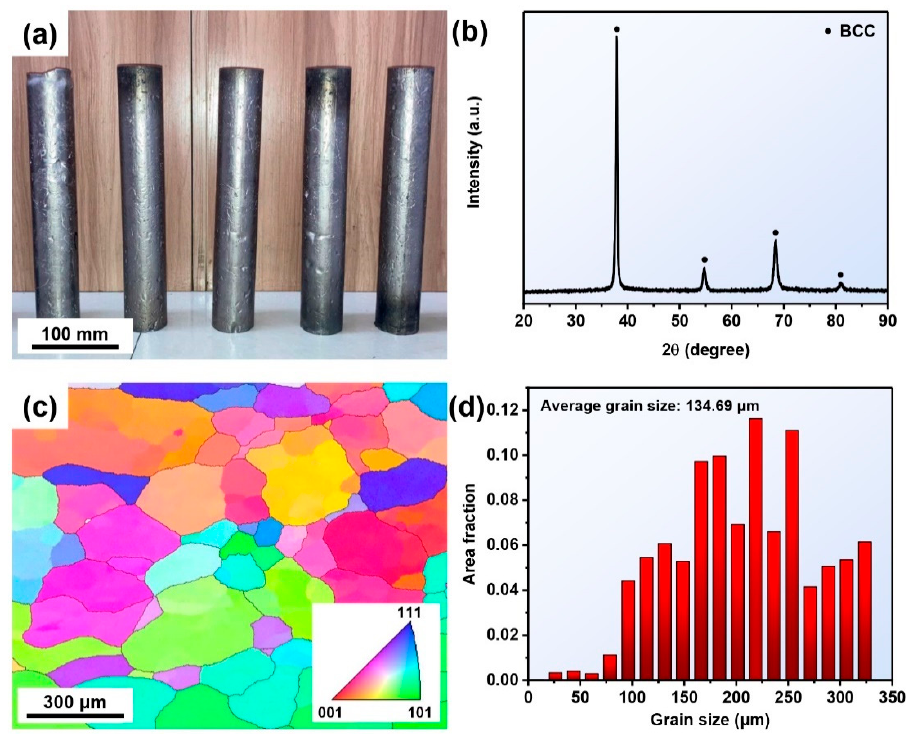
Figure 2. ( a ) TaNbTiZr RHEA bars; ( b ) XRD pattern, ( c ) EBSD IPF map, and ( d ) grain size distribu ‐ tion.